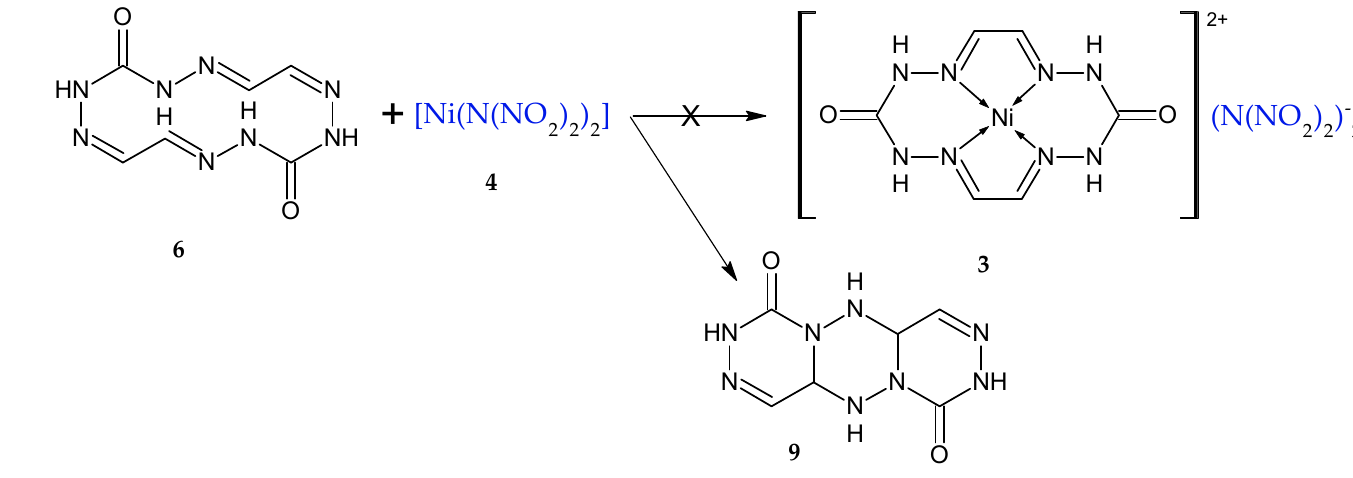
Figure 6. A synthetic scheme for 9 from 3